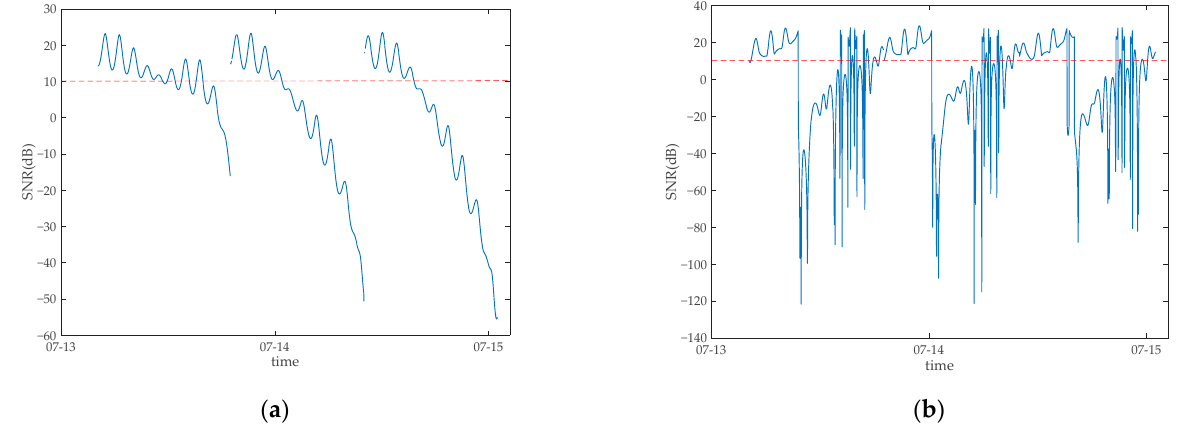
Figure 13. Variation of signal-to-noise ratio with time in inter-satellite terahertz communication sys- tem: ( a ) uplink terahertz communication link for LEO-GEO; ( b ) downlink terahertz communication link for GEO-LEO.